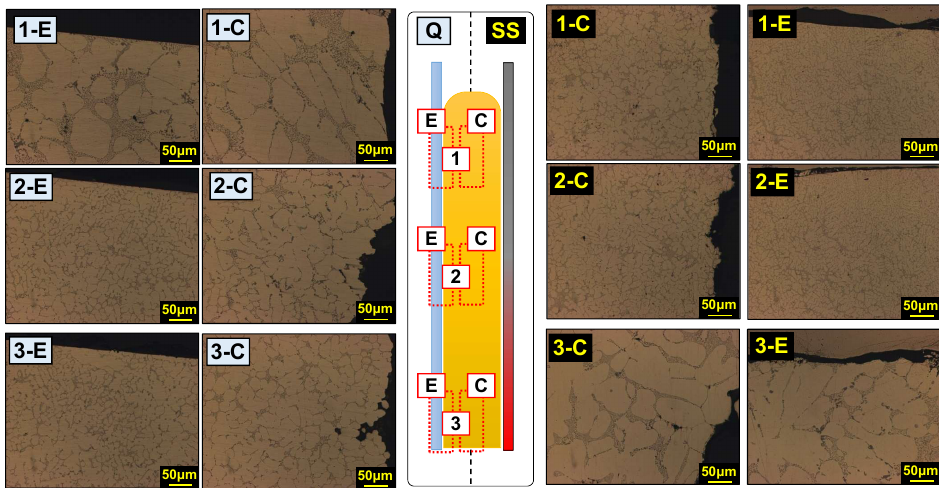
Figure 7. Microstructure of the fluidity samples of the A356 alloy obtained at 650 ◦ C of the melt temperature and 0.01 MPa of the vacuum degree in a quartz tube ( left ) and a stainless steel tube ( right ) after air